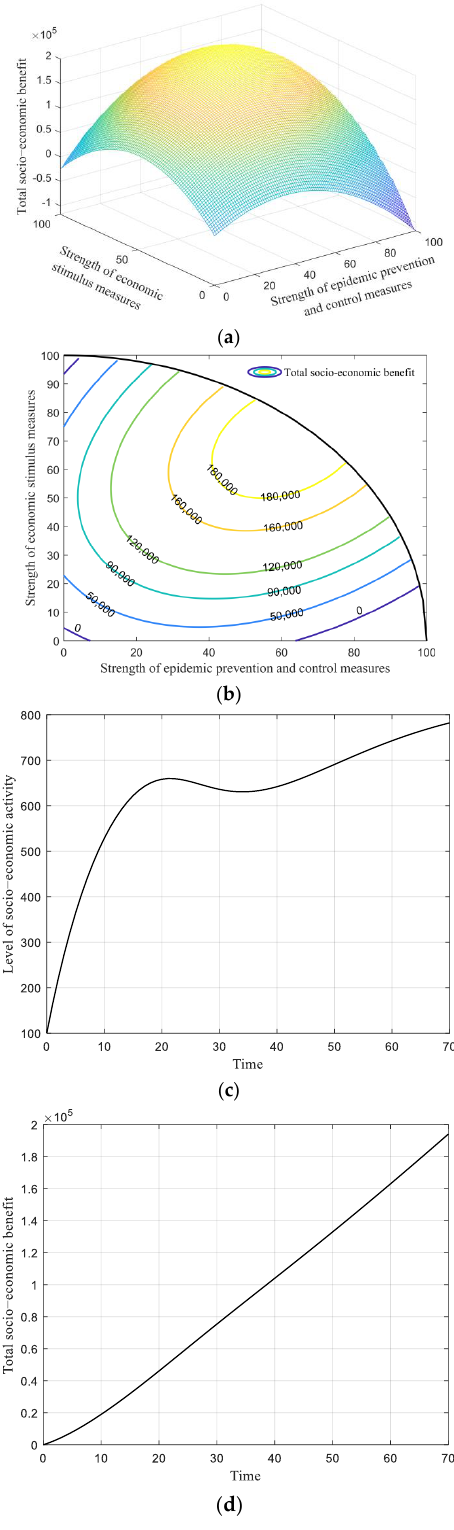
Figure 3. Results of static strategy. ( a ) Total socio-economic benefit with varying strengths of pan- demic prevention and control measures and economic stimulus measures. ( b ) Total socio-economic benefit counters with varying strengths of pandemic prevention and control measures and economic stimulus measures. ( c ) Level of socio-economic activity, along with the time when 𝐸 𝑝 = 62 and 𝐸 𝑠 = 70. ( d ) Total socio-economic benefit, along with when 𝐸 𝑝 = 62 and 𝐸 𝑠 = 70. Figure 3b depicts the counters of total benefit with respect to two control variables.